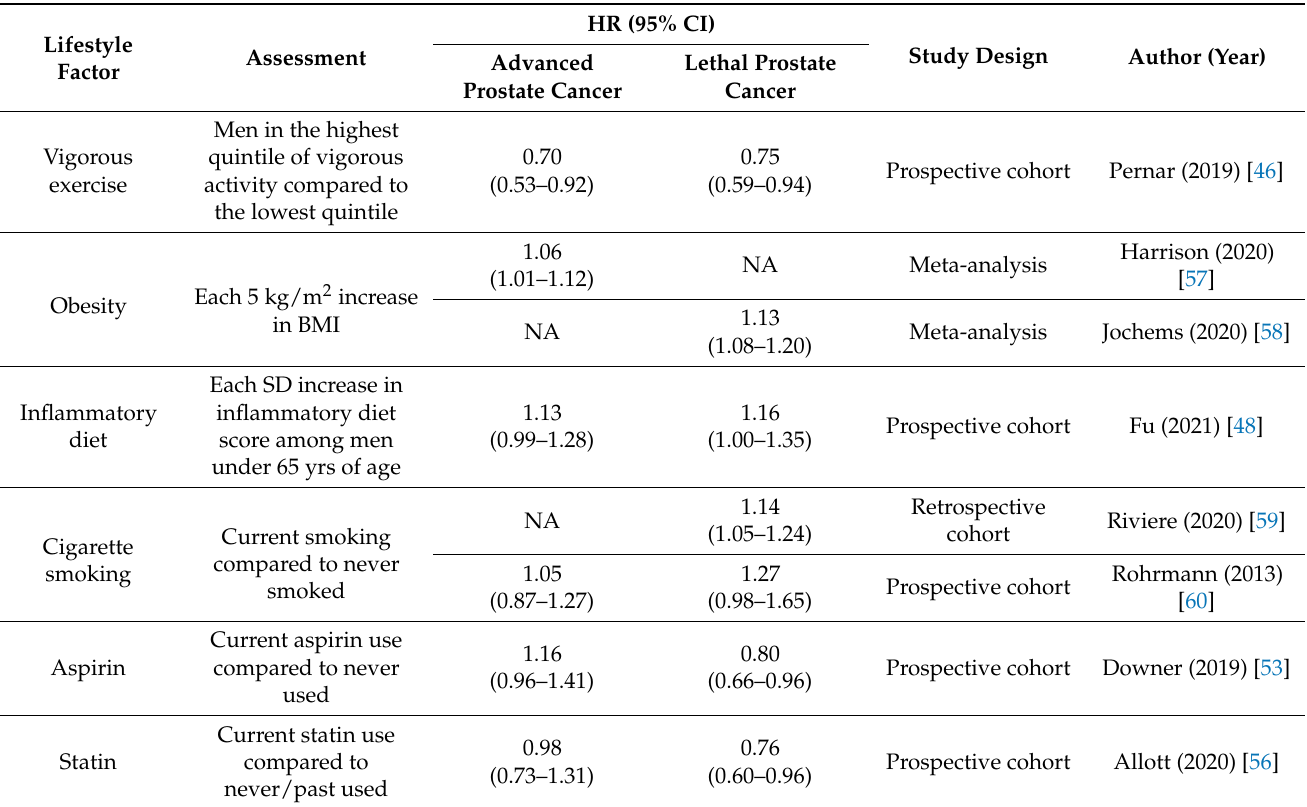
Table 1. Impact of lifestyle factors on advanced and lethal prostate cancer outcomes: evidence from recent